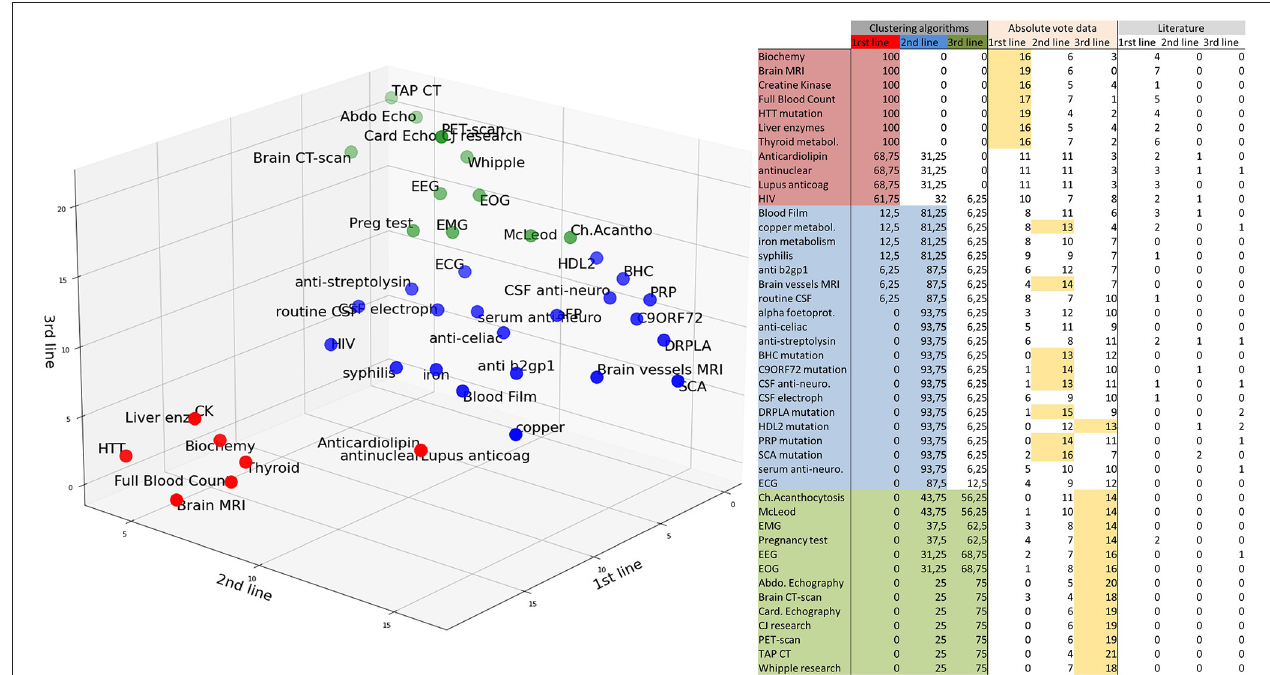
FIGURE 2 | Classification of the paraclinical tests. 1st-line: red, 2nd-line: blue, 3rd-line: green. The results of the clustering algorithms are summed in the left columns (results in % of runs of the algorithms). Absolute numbers of votes are reported in the middle columns as “Absolute vote data.” The majority vote ( > 50% of 25 votes) is highlighted in yellow. Literature results are summarized in the right columns. McLeod: exclusion of the McLeod Kell phenotype by a blood bank (weak Kell antigens and, if available, no reaction with anti-Kx). Ch.acanthocytosis: Western blot for chorein